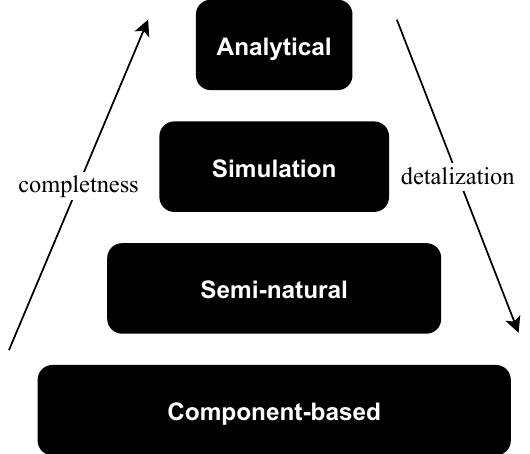
Figure 2. Comparison of modeling